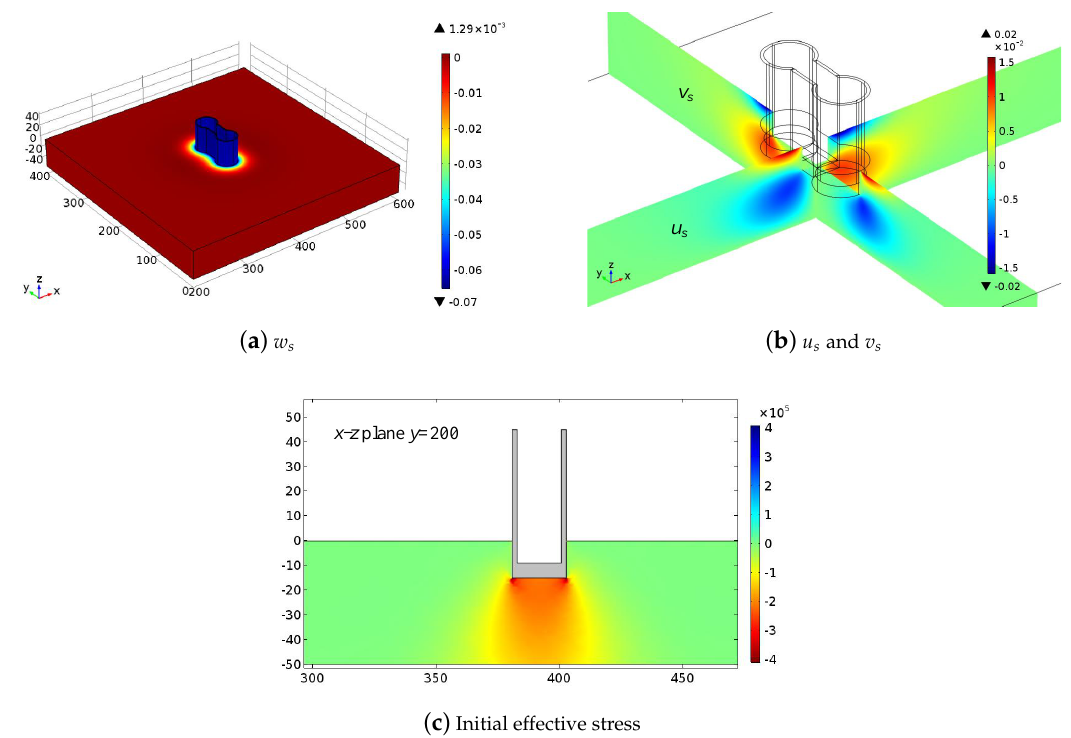
Figure 13. Distributions of the soil displacements near the dumbbell cofferdam after the consolidation of a coarse seabed for Type 33 .